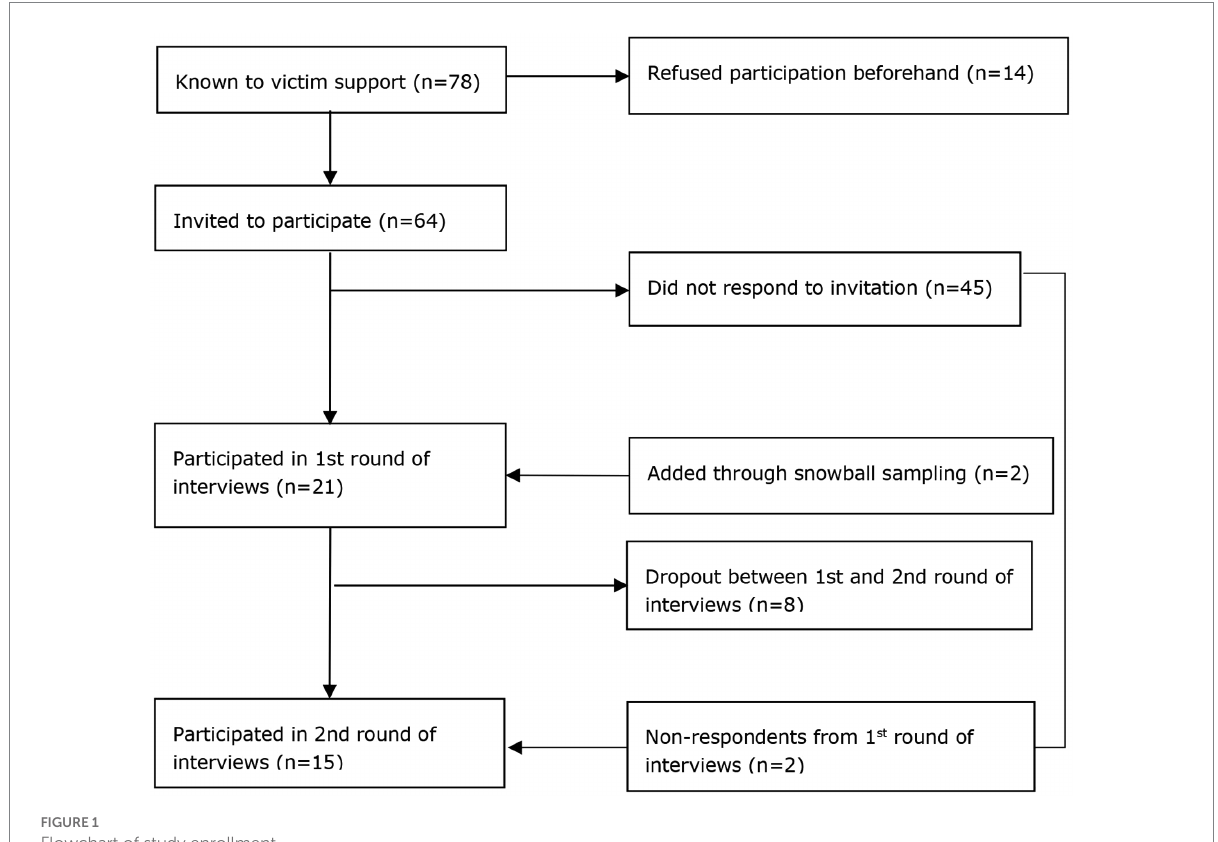
FIGURE 1 Flowchart of study